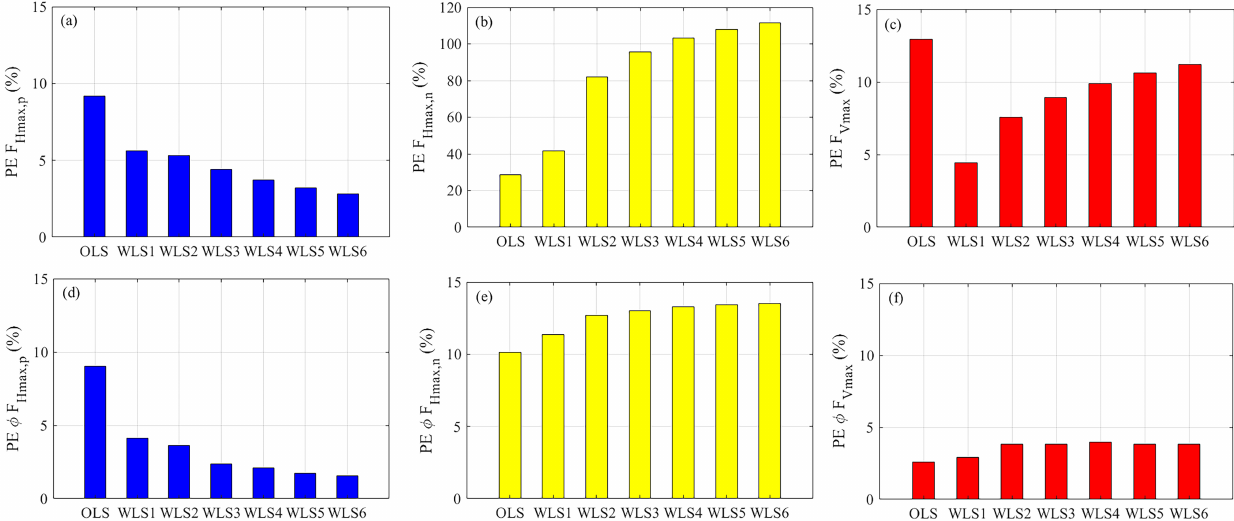
Figure 8. Experimental PE through OLS, WLS1, WLS2, WLS3, WLS4, WLS5, and WLS6 methods. ( a ) Maximum positive horizontal force, F Hmax , p ; ( b ) maximum negative horizontal force, F Hmax , n ; ( c ) maximum vertical force, F Vmax ; ( d ) phase shift, φ , related to F Hmax , p ; ( e ) phase shift, φ , related to F Hmax , n ; ( f ) phase shift, φ , related to F Vmax